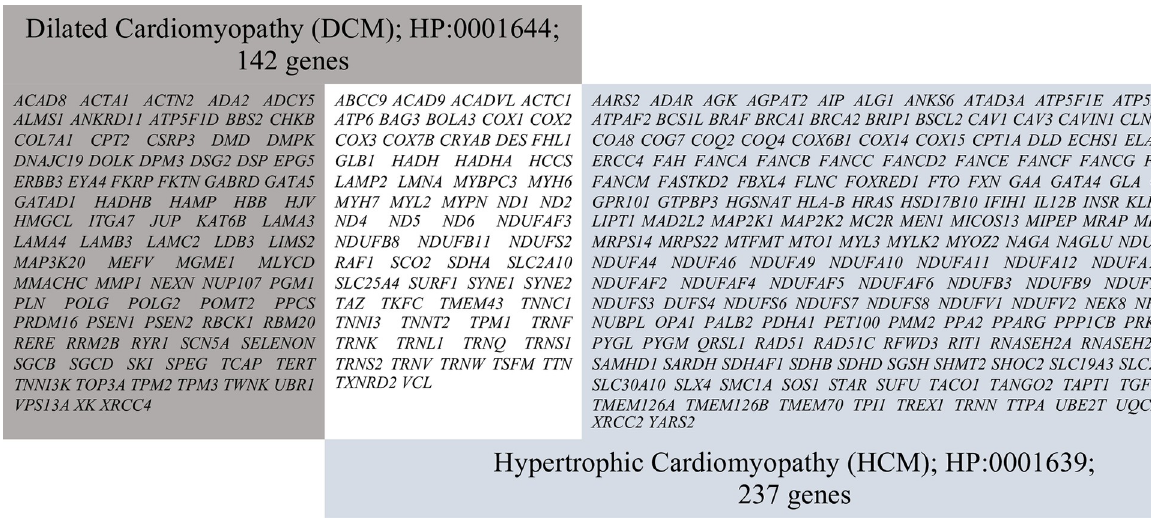
Fig 1. Targeted gene list for hypertrophic and dilated cardiomyopathy. Based on the Human Phenotype Ontology, 237 and 142 genes are listed as the genetic cause of hypertrophic cardiomyopathy (HP:0001639) and dilated cardiomyopathy (HP:0001644), respectively. Of them, 61 genes are described as the etiology of both phenotypes (white